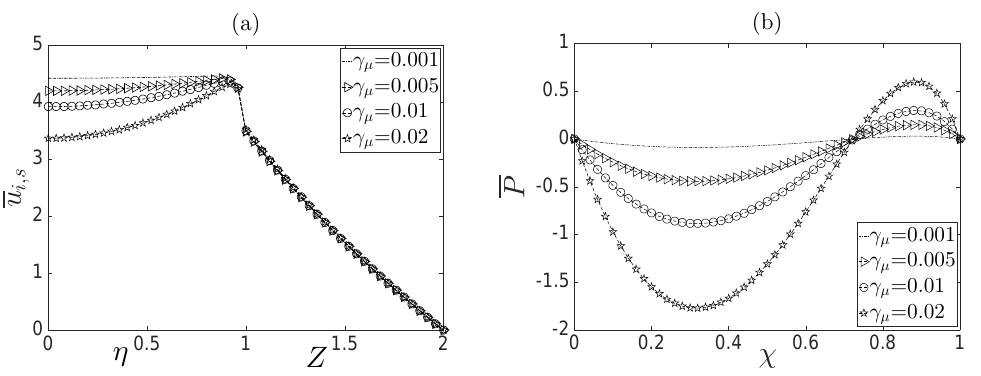
Figure 7. Behavior of the electroosmotic flow: ( a ) dimensionless velocity profile, evaluated at χ = 0.5, and ( b ) dimensionless pressure along the